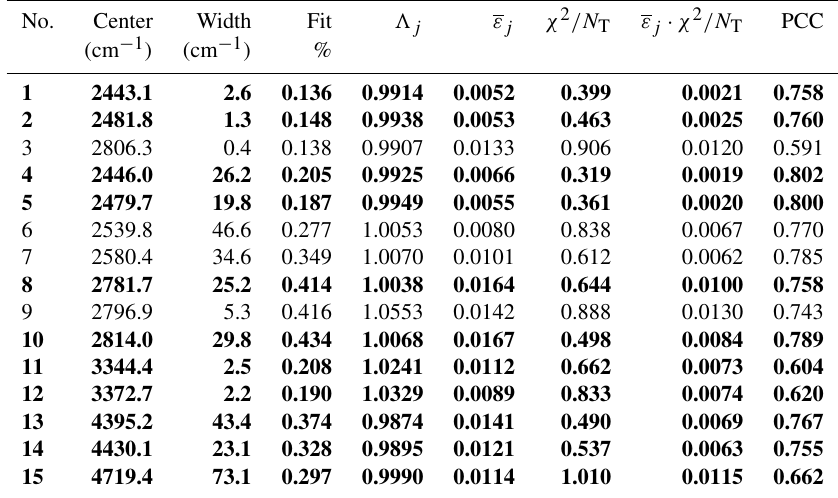
Table C2. Statistical properties of the N 2 O retrievals and xN 2 O amounts retrieved from the 15 investigated windows. The symbols (cid:51) j , ε j , and χ 2 /N are defined in Appendix B. Windows in bold font denote those accepted in the subsequent analyses. So 11 windows were accepted and 4 were not. The PCC values are generally smaller than those of OCS, reflecting the smaller variations in atmospheric xN 2 O in comparison with the measurement